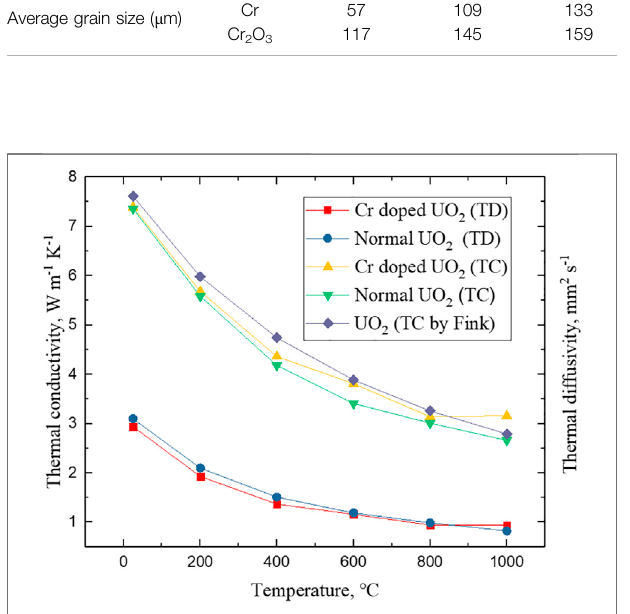
FIGURE10 | The thermal diffusivity(TD) and thermal conductivity (TC) of large grain UO 2 and normal UO 2 .